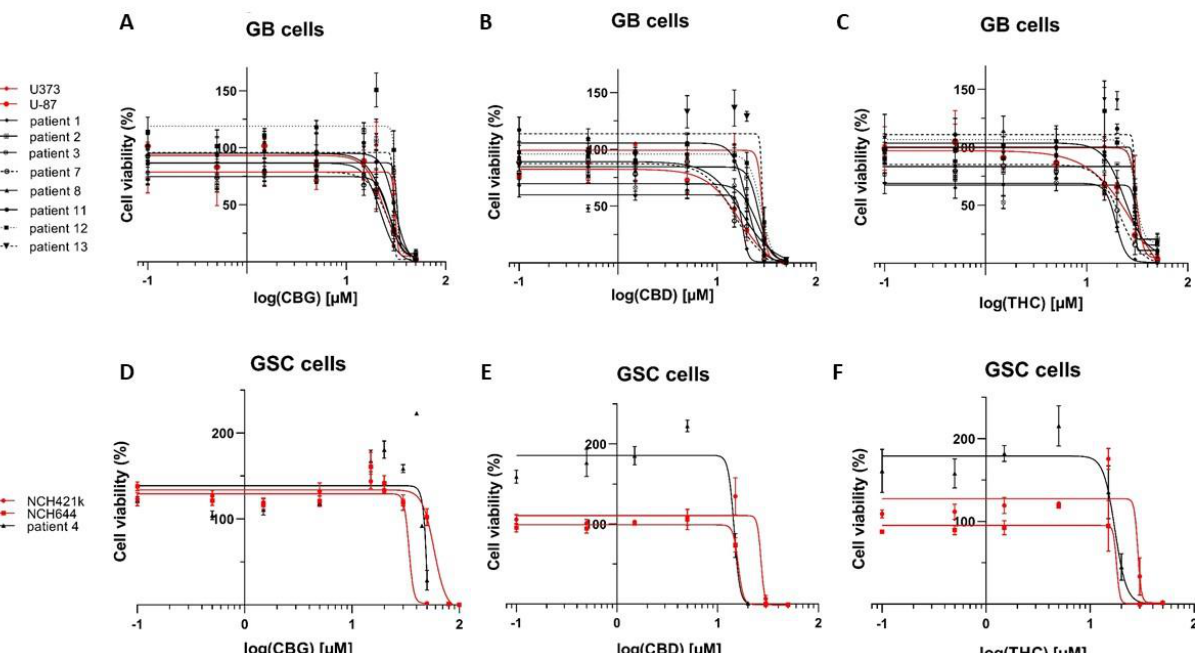
Figure 1. Cannabinoids reduce viability of GB and GSC cells. CBG ( A , D ), CBD ( B , E ), and THC ( C , F ) impaired the viability of differentiated GB cells and GSCs. Dose responses of cell viability measured by MTT assay (y-axis) and different CBG, CBD and THC concentrations increasing in the range of 0.1–50 µM (x-axis log scale) on established GB cells (U87 and U373) ( A – C ; red lines) in comparison to primary patient-derived GB cells ( A – C ; black lines). Established GSC lines NCH421k and NCH644 ( D – F ; red lines) are compared to primary patient-derived GSCs ( D – F ; black line) after 48 h of a single treatment with cannabinoids. Data are expressed as mean ± SE ( n = 3–5 independent biological experiments, each in technical triplicate). Vehicles comprised ≤ 0.1% ( v / v ) DMSO for THC and CBD and 0.24% ( v / v ) ethanol for CBG. The methodology taken from Deng et al. [41] is described in great detail in Material and Methods (Section 2.5).